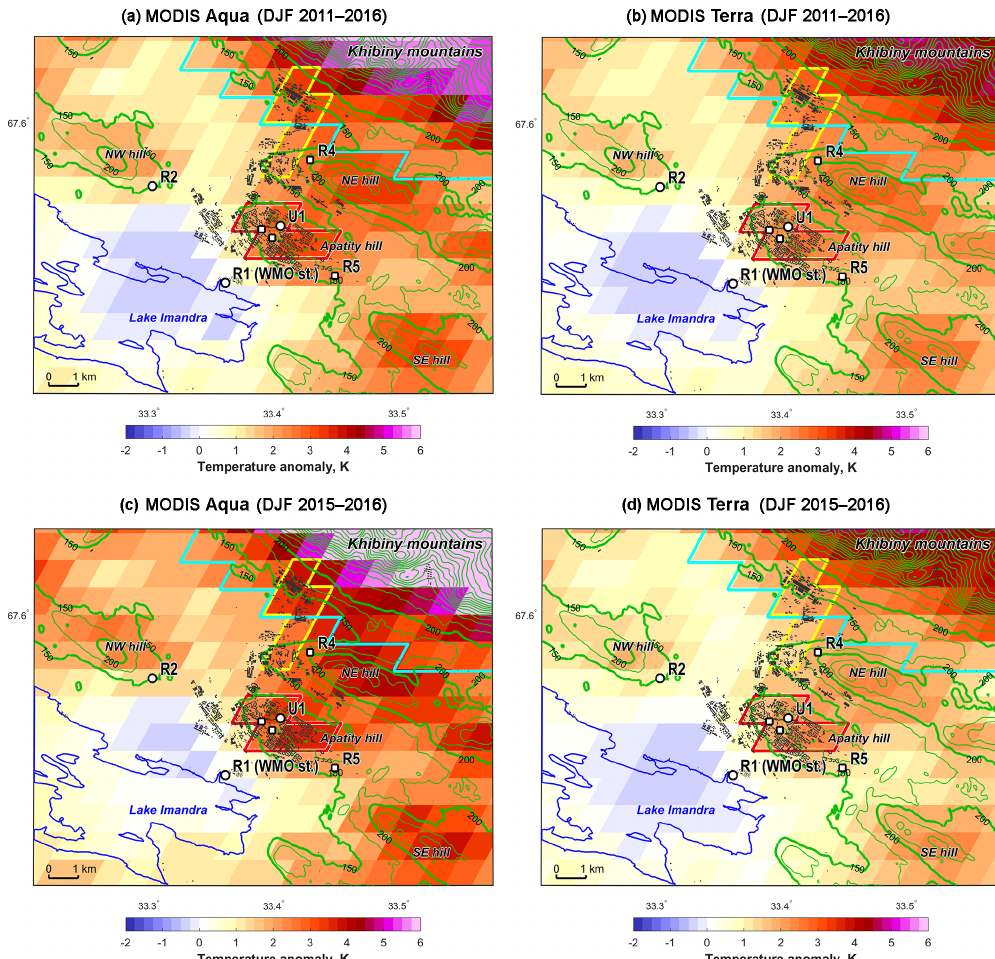
Figure 6. The mean winter (DJF – December, January, February) land surface temperature (LST) anomaly obtained from satellite remote sensing with the MODIS instruments onboard the Terra and Aqua satellite platforms for (a, b) the longer period from 2011 to 2016 and for (c, d) the period from 2015 to 2016, which is synchronized with the long-term UHIARC in situ measurements in Apatity. The LST anomaly is calculated as the difference in temperature from the temperature of the pixel collocated with the R1 station. The red lines encompass the pixels classified as the urban area, the yellow lines denote the industrial area and the cyan lines encompass the Khibiny mountain area.